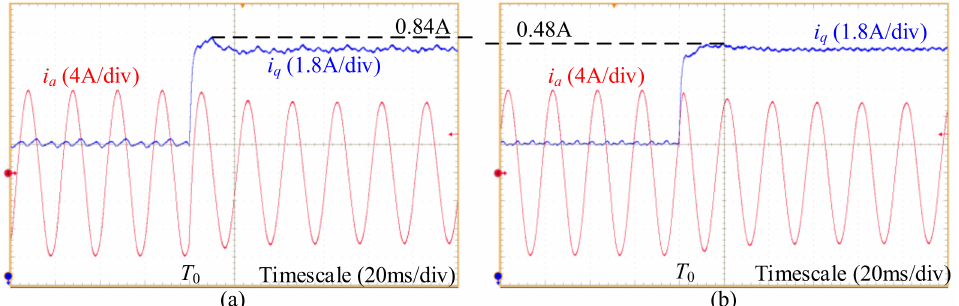
Figure 14. Dynamic response of q -axis component of grid current with its reference changes from − 6 A to 0 A at time T 0 : ( a ) SRF-PLL; ( b ) DSOGI-FLL is used for grid